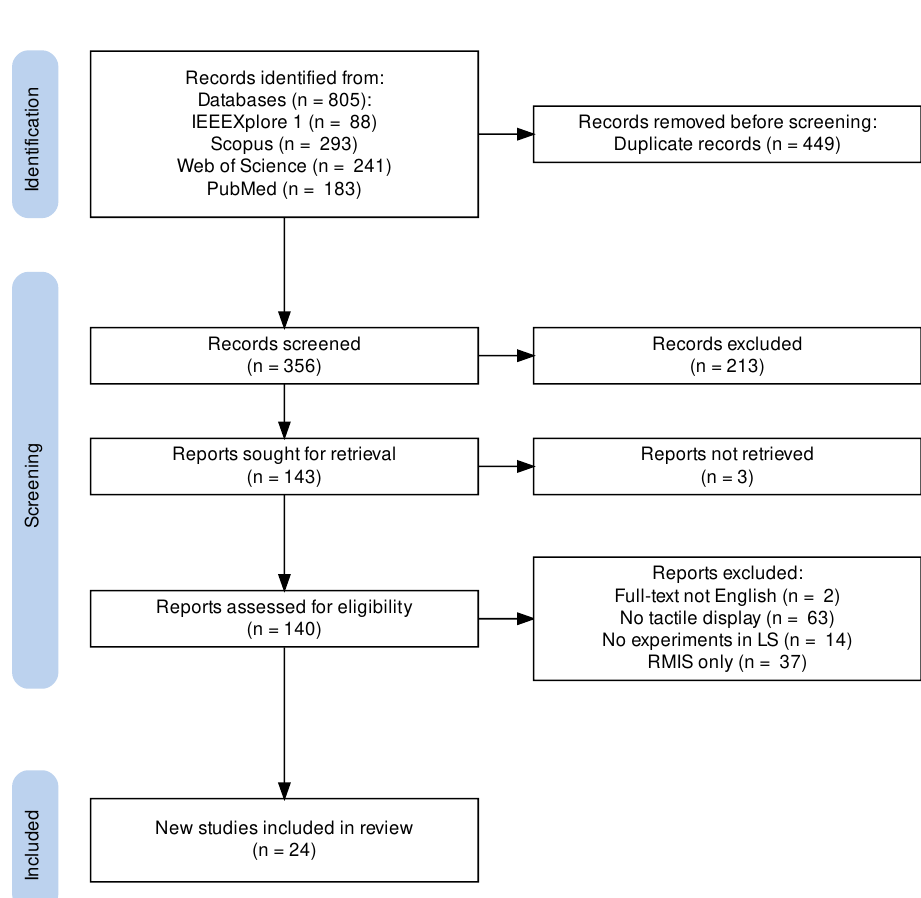
Figure 2. The study selection